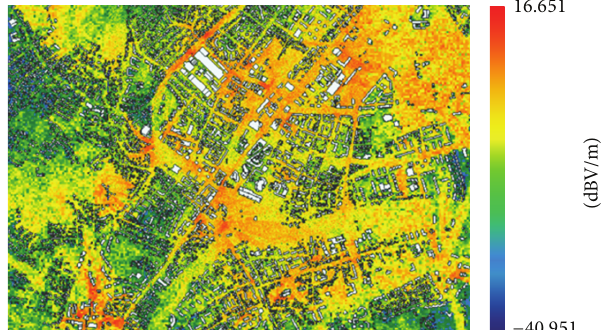
Figure 10: Total electric field strength prediction map of DCS1800 MHz mobile service.